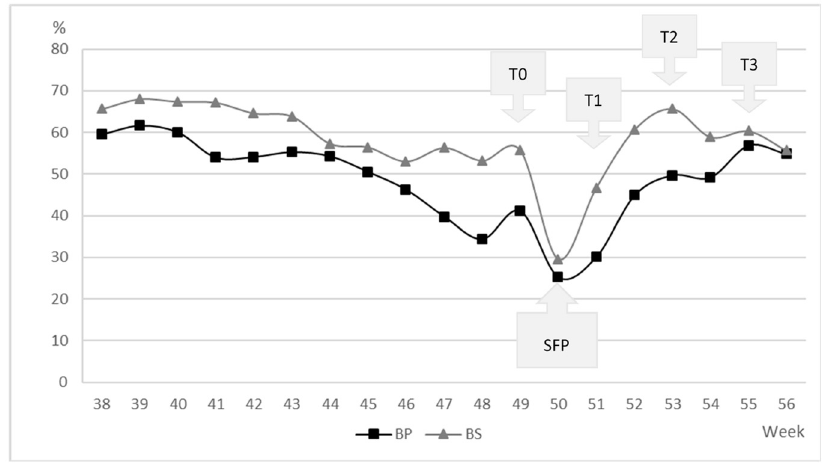
Figure 1. Egg-laying rate (%) of Bianca di Saluzzo (BS) and Bionda Piemontese (BP) laying hens from 38 to 56 weeks of age. T0: 1-week pre-Stressful Farming Practice (SPF); T1: 1-week post-SFP; T2: 3-week post-SFP; T3: 5-week post-SFP.